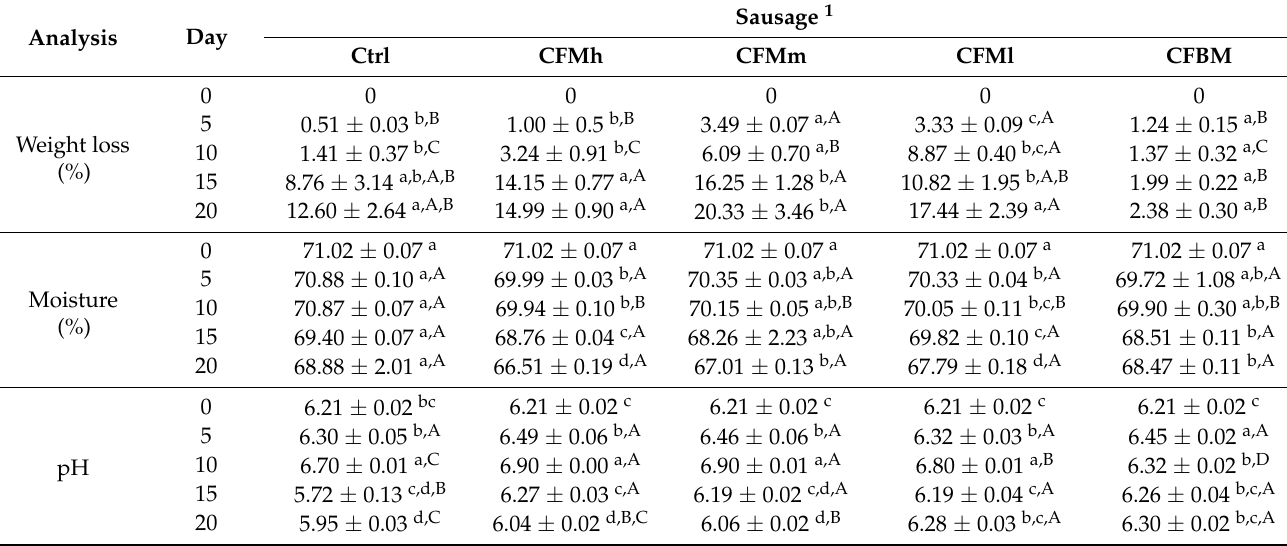
Table 4. Weight loss, moisture and pH values in sausages of uncovered sausages (Ctrl) and those covered with